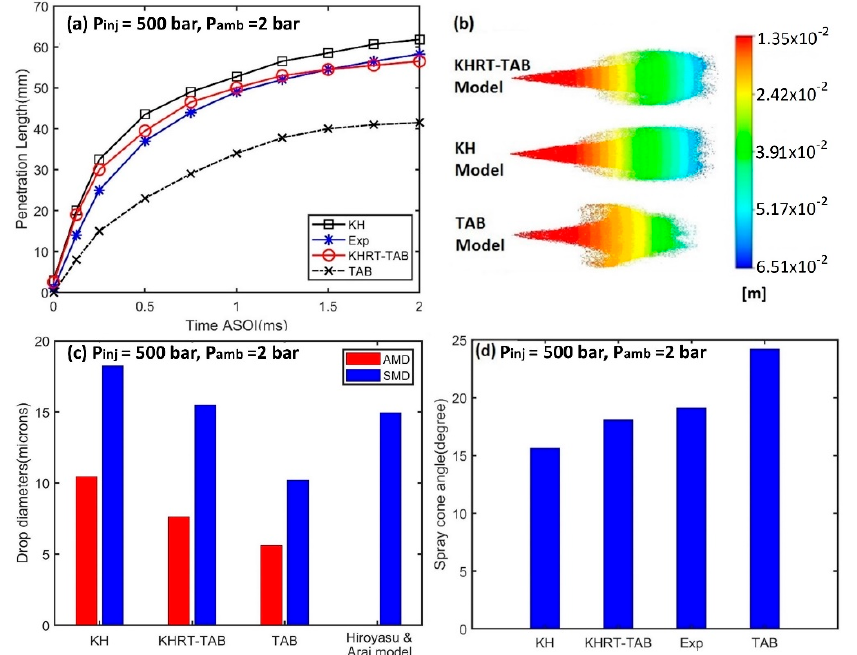
Figure 7. Comparison of spray simulation with experimental results at IP of 500 bar with 2 bar ambient pressure for: ( a , b ) Spray penetration length, ( c ) numerical results showing AMD (red) and SMD (blue) for various breakup models compared with Hiroyasu and Arai Model [54], and ( d ) spray cone angle and its comparison with experimental observations.